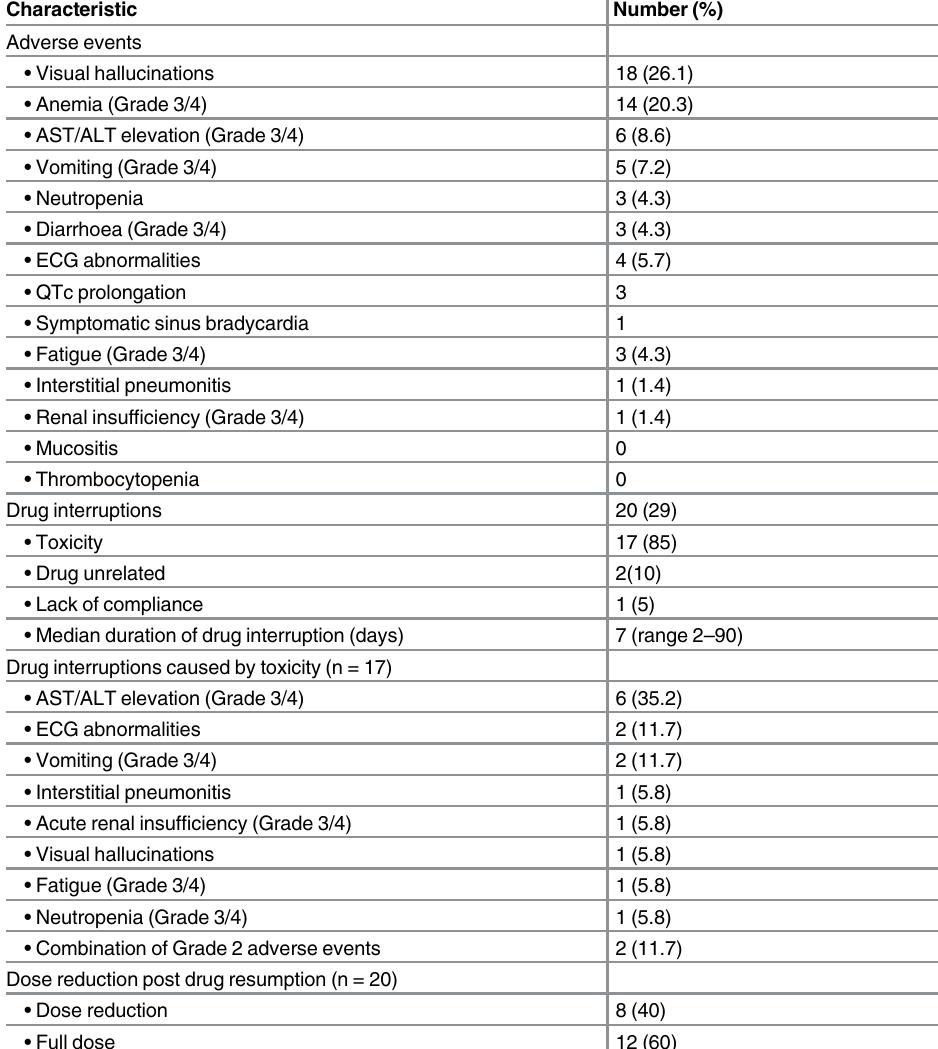
Table 3. Adverse Events and